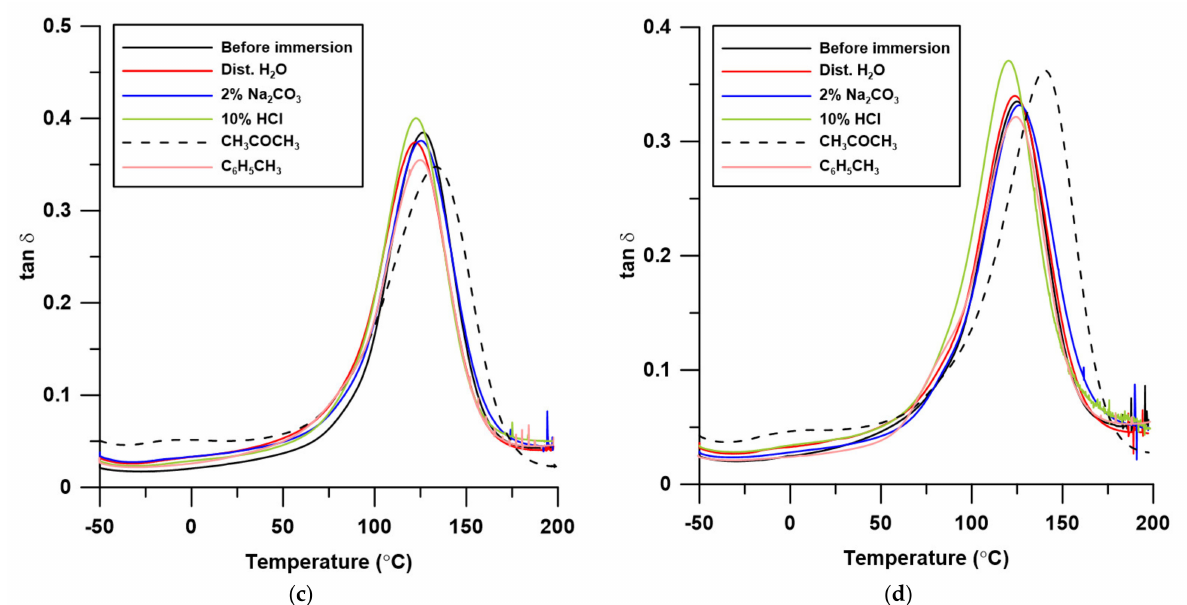
Figure 11. The temperature-dependent graph of damping factor (tan δ ): ( a ) Pure UPR; ( b ) UPR + 10; ( c ) UPR + 20; ( d ) UPR +